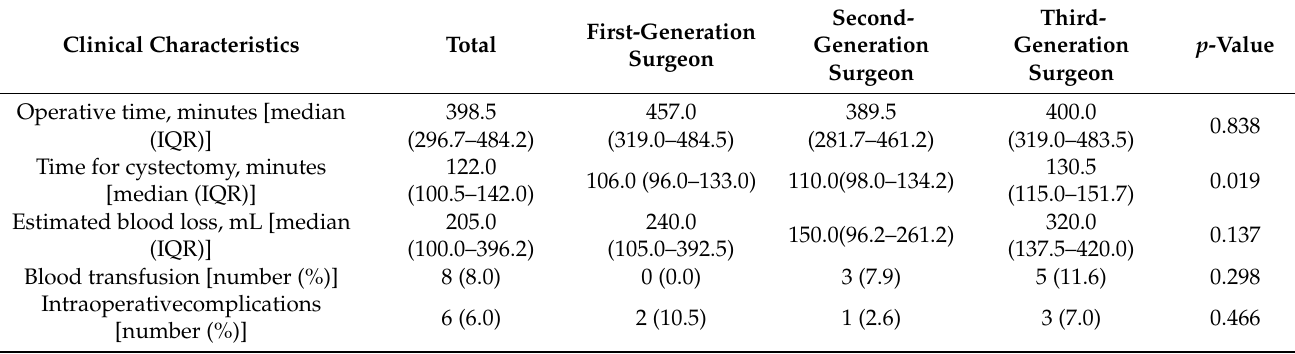
Table 2. Surgical and perioperative